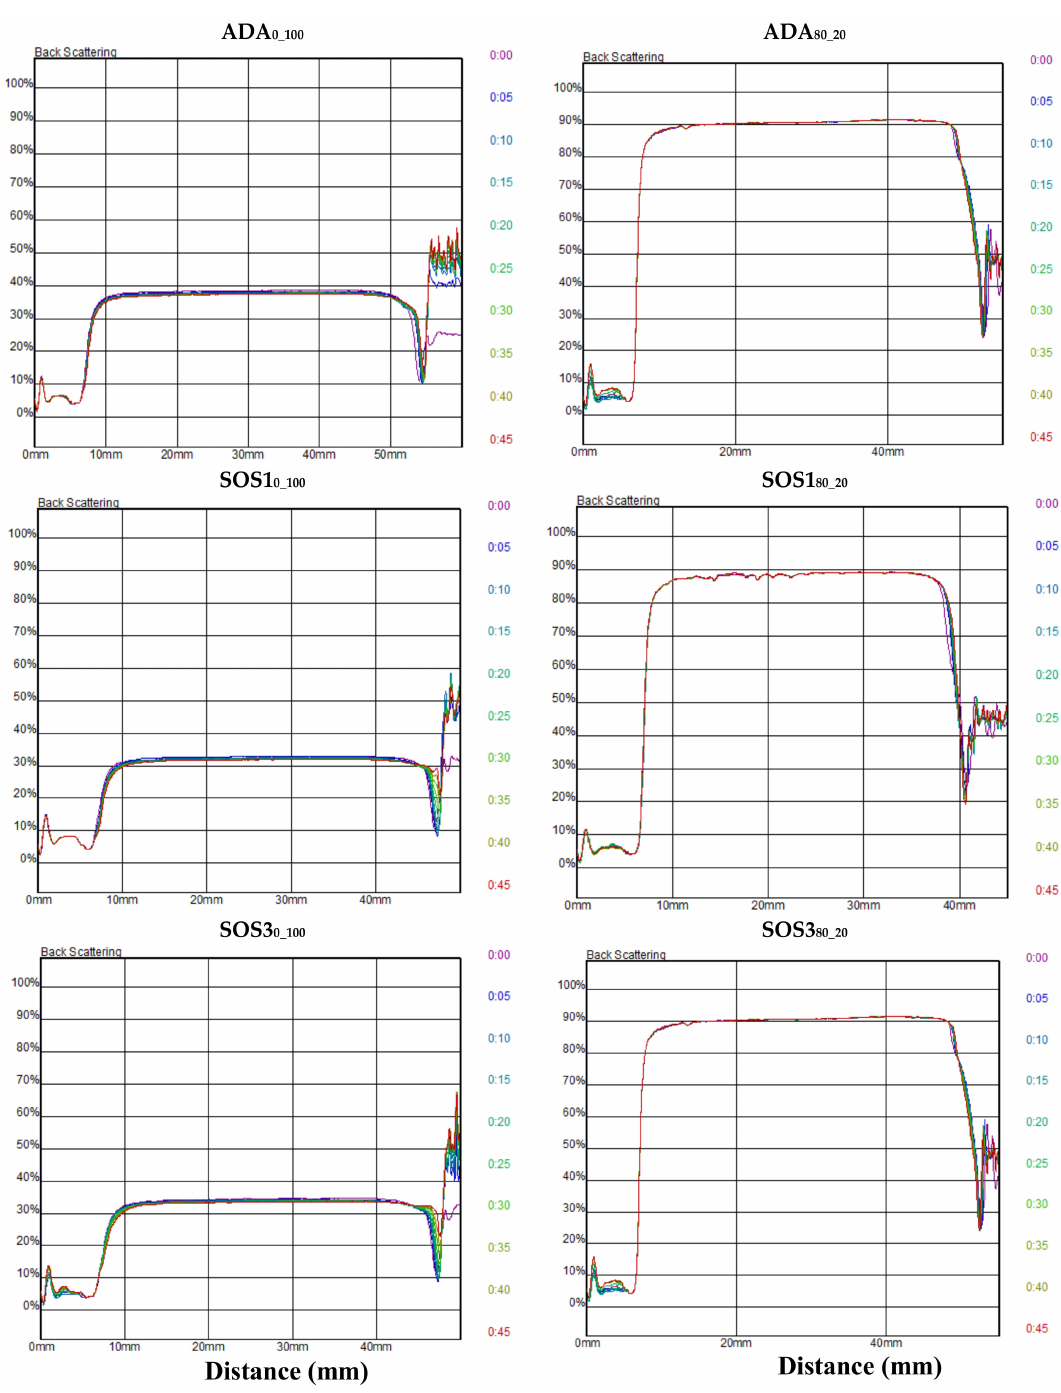
Figure 5. Back scattering ( Y -axis, %) vs. distance ( X -axis, mm) profiles of feed emulsions of the three starch grades: ADA, SOS1, and SOS3 stabilized with polysaccharides only (ADA 0_100 , SOS1 0_100 , SOS3 0_100 ), or polymer / polysaccharides 80 / 20 (ADA 80_20 , SOS1 80_20 , SOS3 80_20 ). (Di ff erent color curves correspond to di ff erent measurements taken at increasing 5 min time